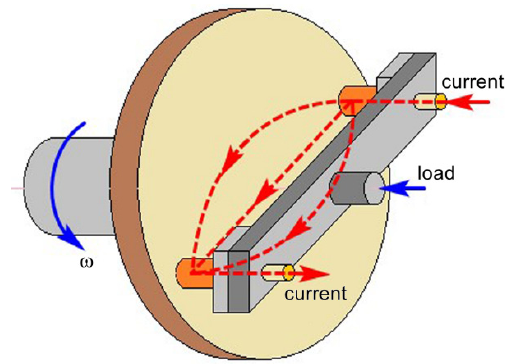
Figure 1. Basic schematic of the HST-100 high speed pin-on-disc tribo-tester.